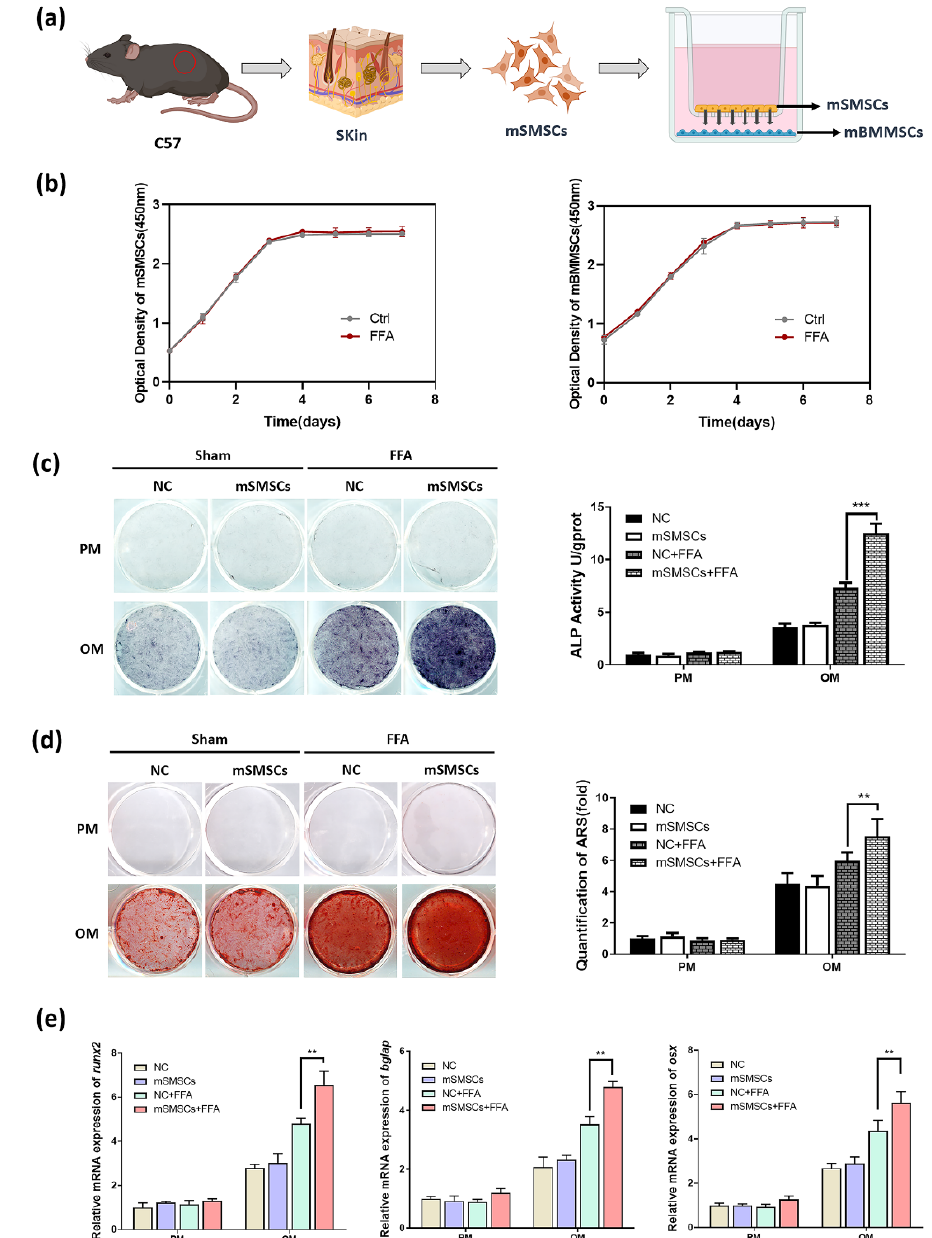
Figure 3. Co-culture with mSMSCs promoted osteogenesis of mBMMSCs in the presence of a low concentration of FFA. ( a ) The process of obtaining mSMSCs and the pattern of mSMSC and mBMMSC growth in co-culture. ( b ) Cell proliferation values for two groups, obtained using the Cell Counting Kit-8 on days 1, 2, 3, 4, 5, 6, and 7. ( c ) ALP staining and quantification showing that co-culture with mSMSCs markedly increased ALP activity in mBMMSCs in the presence of FFA. ( d ) ARS staining and quantification showing that co-culture with mSMSCs significantly accelerated mBMMSC mineralization in the presence of FFA. ( e ) qRT-PCR showing that co-culture with mSMSCs increased the mRNA expression of runx2 , bglap , and osx in mBMMSCs in the presence of FFA. ** p < 0.01, *** p < 0.001.